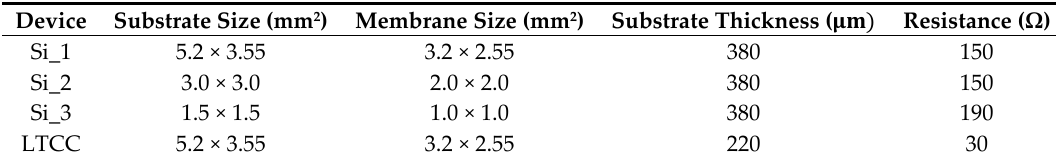
Table 1. Micro-hotplates design